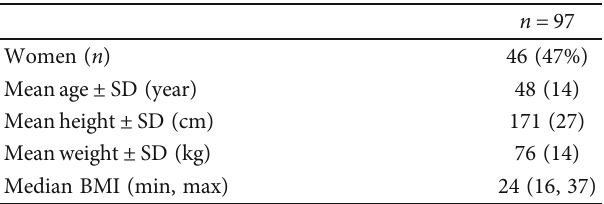
Figure 2: Parallel ECG recordings with ECG247 Smart Heart Sensor and Schiller Cardiovit AT-102 G2 ECG recorder. Table 1: Clinical characteristics.